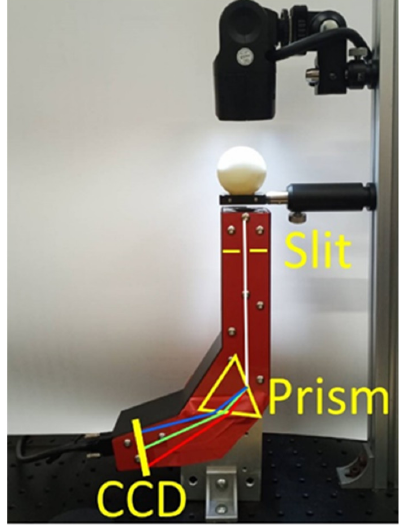
Figure 1. Duck egg transmission measurement spectrometer. The xenon flash is located at the top as the light source. Light passes through the lens and then enters the inhouse optical prism spectrometer at the bottom after penetrating the egg. The “CCD” in the figure means “charge coupled device”.